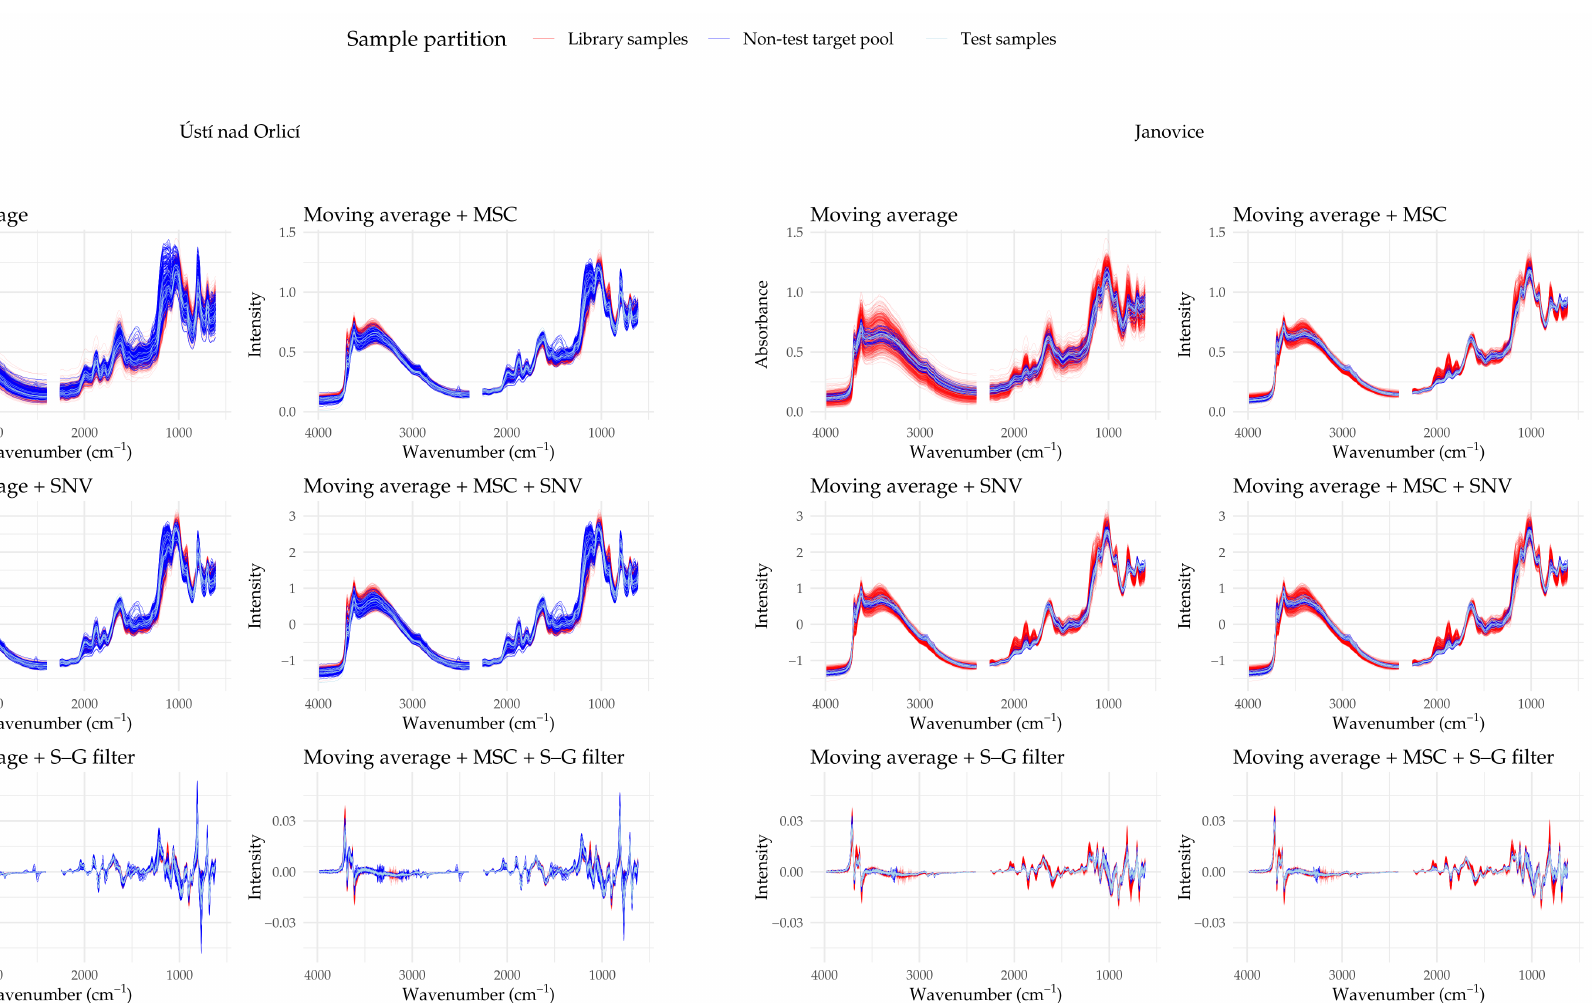
Figure 4. Pre-processed library and target-site spectra. The reference spectrum for the multiplicative scatter correction (MSC) transformation is based on the first training-pool–test